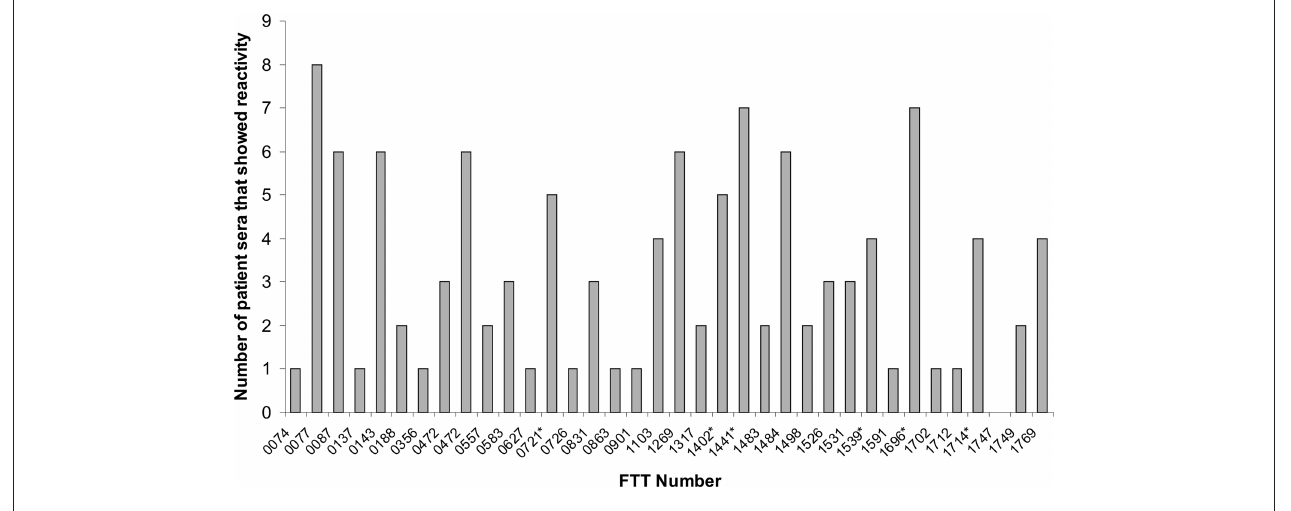
ORF within the SCHU S4 genome sequence. *Indicates that sera reacted with isoforms of the same protein, shown is the highest observed frequency of reactivity. These data were originally reported by and tabulated in Havlasova et al.